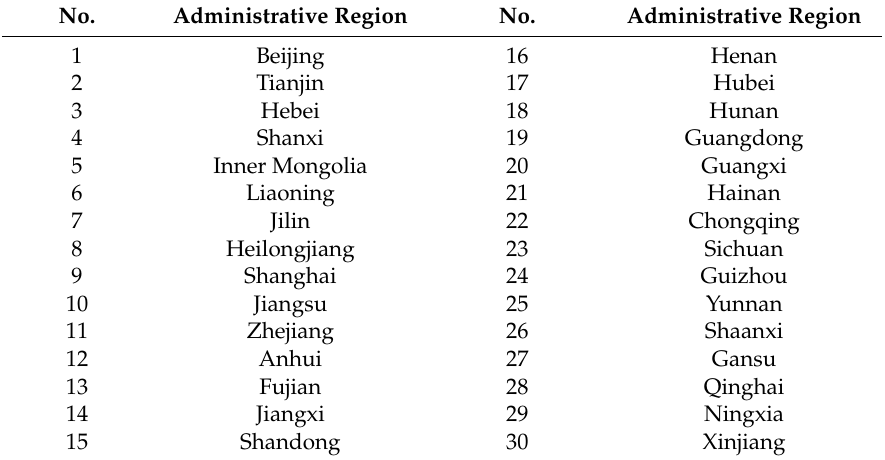
Table 1. Administrative regions analyzed in the research.